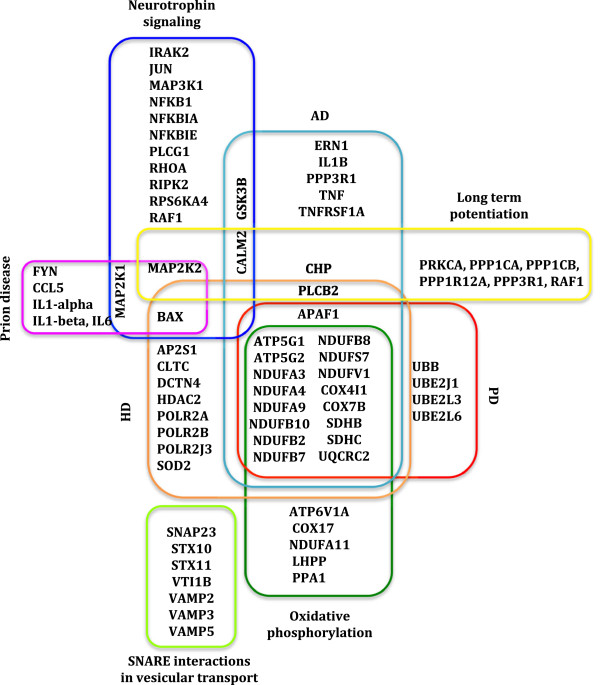
Illustration of altered DE genes in neurological disease-related pathways. Representation of DE genes between PBMCs from HIV positive individuals and healthy controls, which fell into statistically significant enriched neurological disease-related pathways. Different colors have been adopted to highlight DE genes in individual pathways.